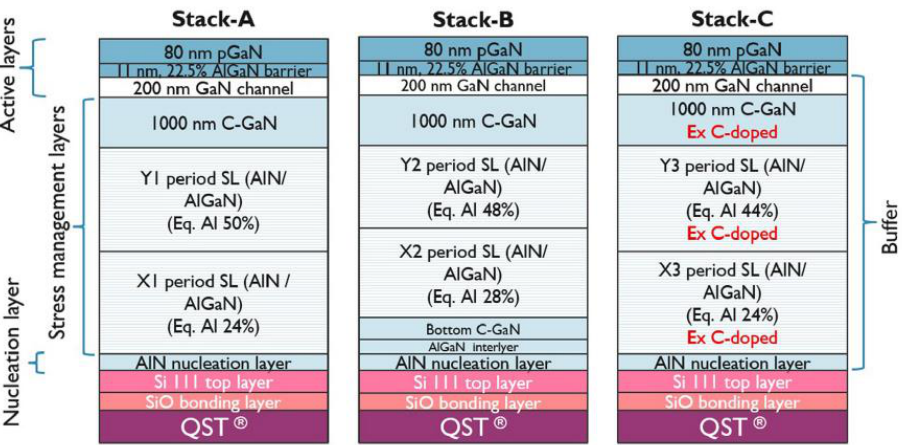
Figure 3. HEMT stacks based on intrinsic (stack A and stack B) and extrinsic (stack C) C-doping developed in this study. Buffer thicknesses of stack A and stack B vary from 5.3–7.4 to 4.8–6.1 µm, respectively. Stack C has a thickness of ∼ 6.8 µm [81]. Figure reproduced with permission from AIP Publishing Applied Physics Letters.